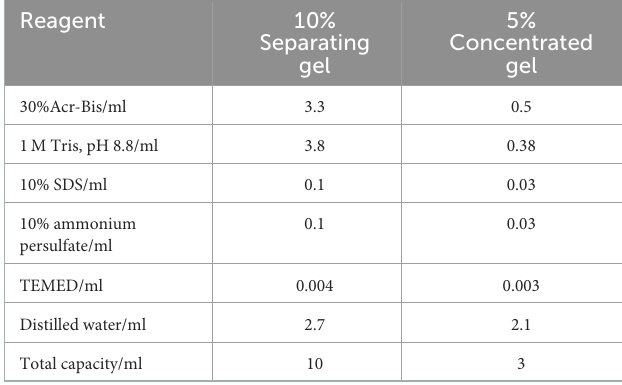
TABLE 2 Preparation of separating glue and concentrated